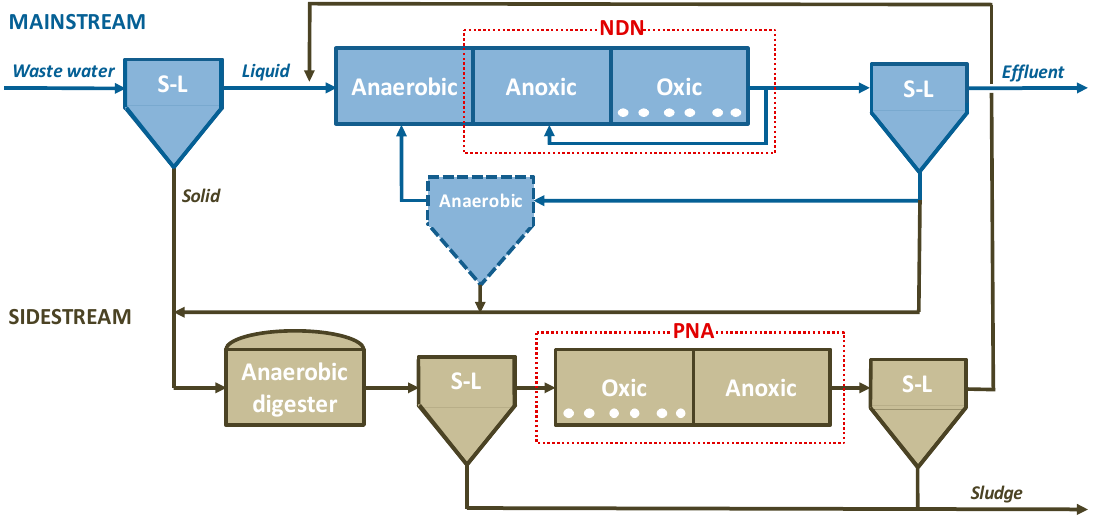
Figure 4. Example of layout for a biological waste water treatment system including the main- and side-stream. Potentially, P recovery by precipitation can be performed before, together with, or after N removal (it concerns bioprocesses such as NDN and PNA). Particular schemes will vary depending on the specificities of the treatment to be applied.